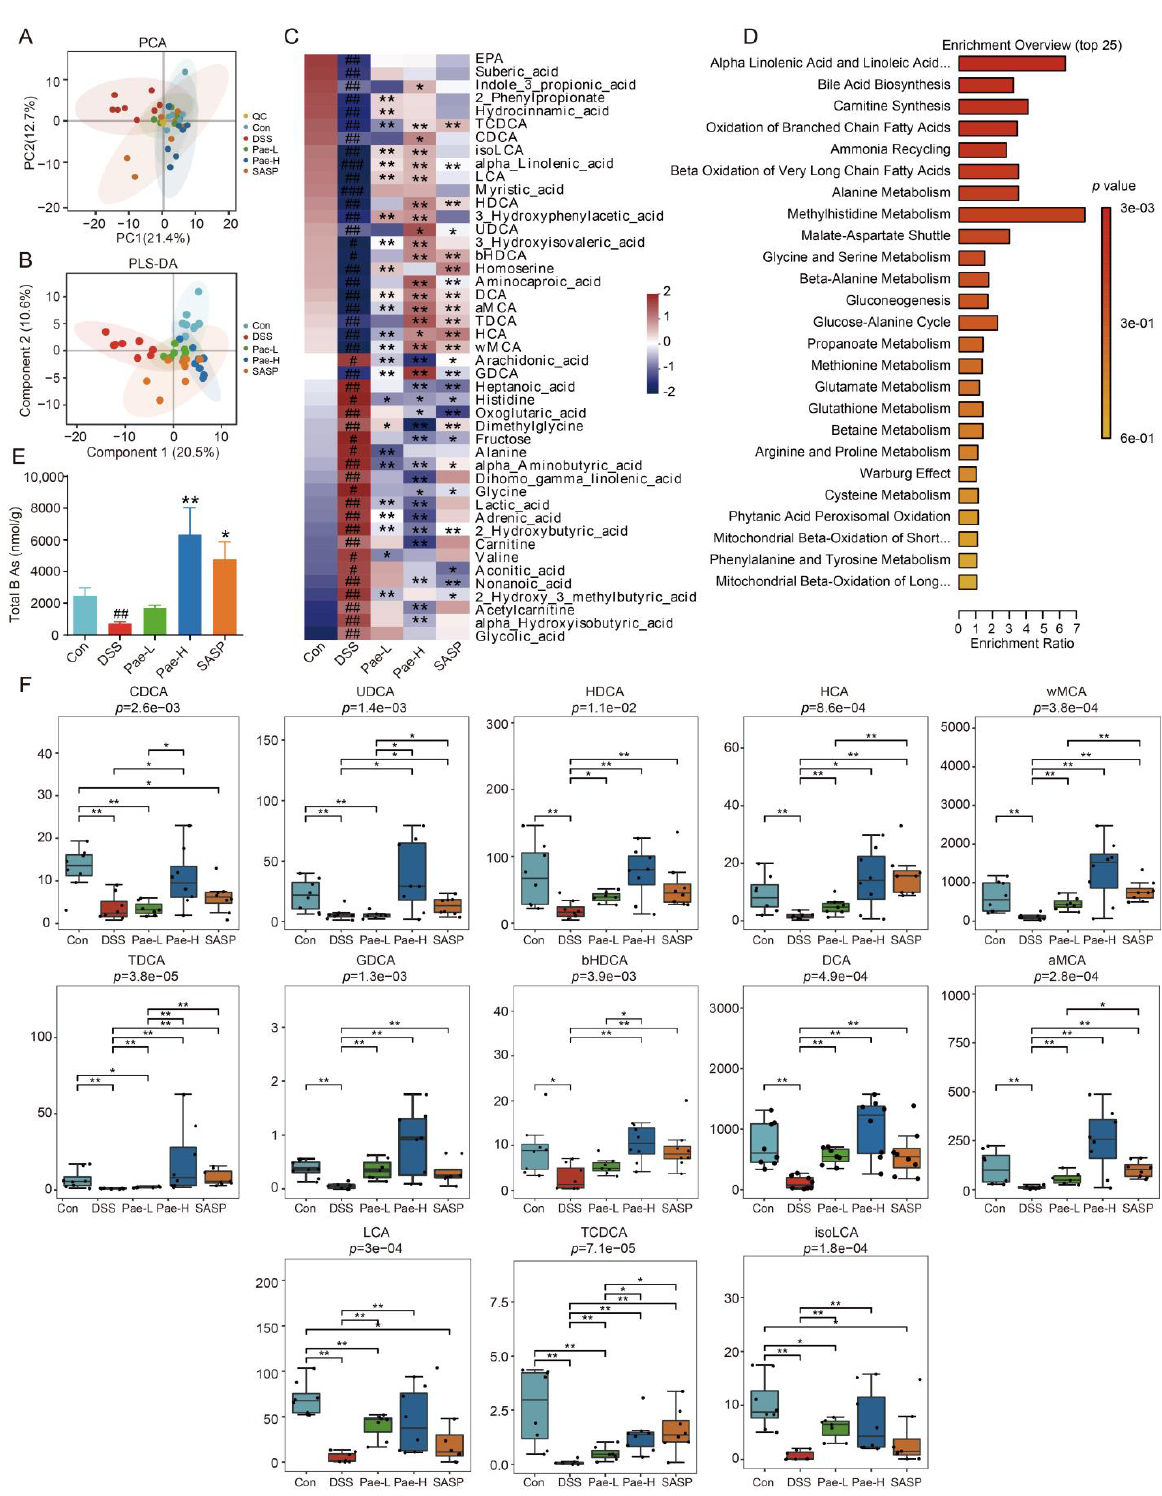
Figure 5. Effects of Pae on fecal metabolism in DSS-induced UC mice. ( A ) Principal Component Analysis (PCA) score plot of Con, DSS, Pae-L, Pae-H and SASP groups and QC samples. ( B ) Partial Least Squares Discriminant Analysis (PLS-DA) score plot from Con, DSS, Pae-L, Pae-H and SASP groups. ( C ) Heatmap of fecal differential metabolite profiles in mice. ( D ) Metabolic pathway enrichment analysis. ( E ) Total BA concentrations in fecal contents. ( F ) Quantitative abundance of significantly altered BAs from different groups (nmol/g). Date are shown as mean ± sem. n = 7 or 8.# p < 0.5; ## p < 0.01; ### p < 0.001, compared with Con group, * p < 0.5; ** p < 0.01, compared with DSS